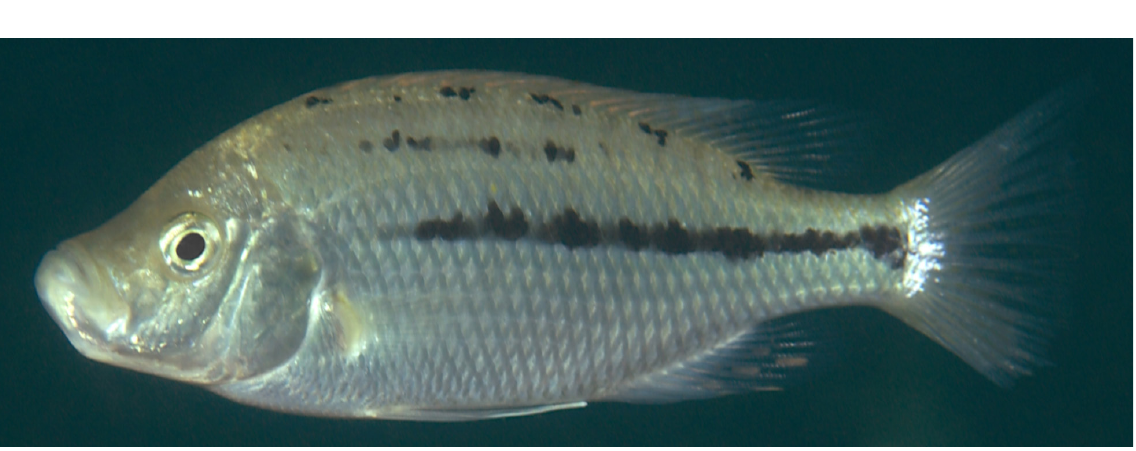
Fig. 6. Photograph of live specimen of Protomelas krampus sp. nov. (specimen not preserved; length unknown) (copyright Ad